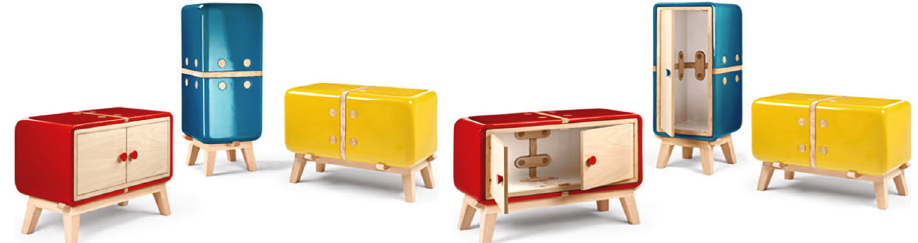
Figure 1: Schematic diagram of the closing and opening of the Keramos cabinet door with ceramic furniture wardrobe